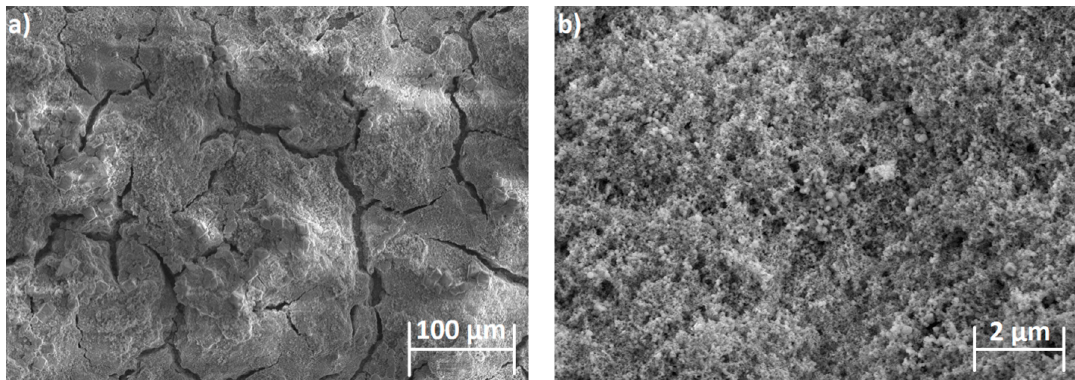
Figure 2. HRSEM pictures of HA with Re:IF-MoS 2 nanoparticles coating obtained from solution A on porous titanium substrate in two magnifications: ( a ) 100 μ m ; ( b ) 2 μ m. The film is continuous but visibly is heavily cracked.